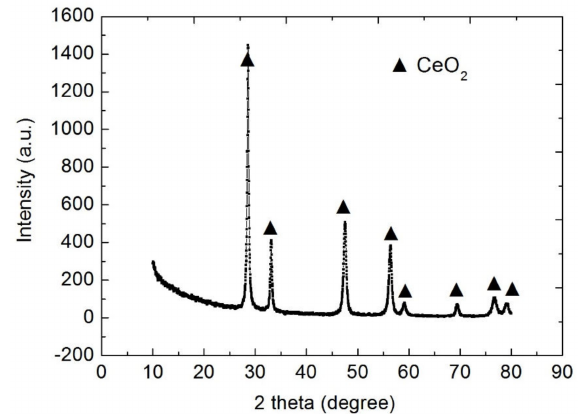
Figure 6. XRD patterns of CeO 2 .